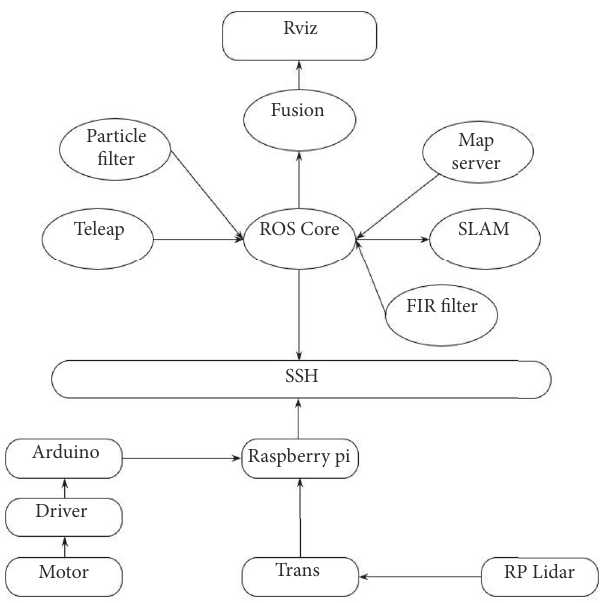
Figure 3: View of the software structure of robot controller.